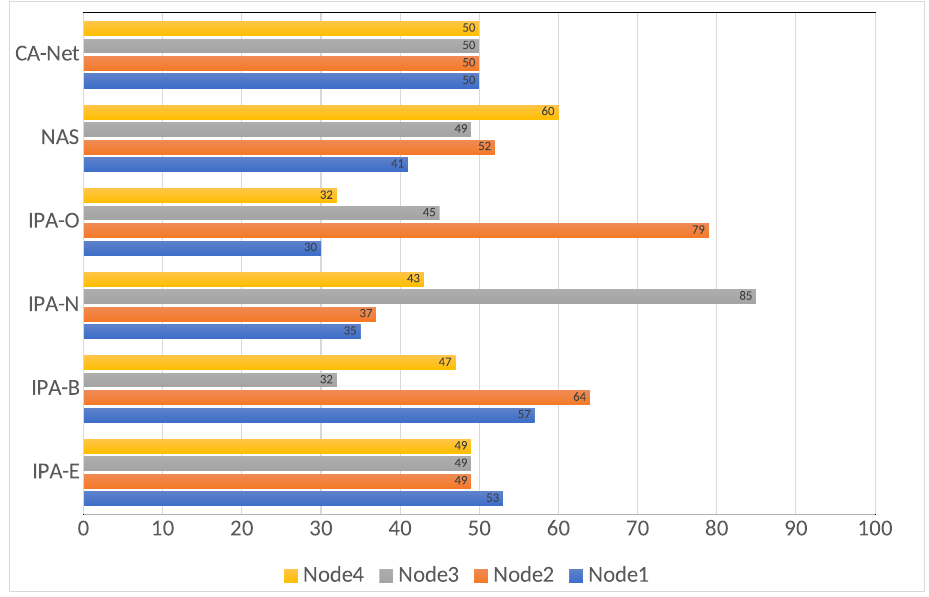
Figure 7. Jobs executed in each node, for the 120 s